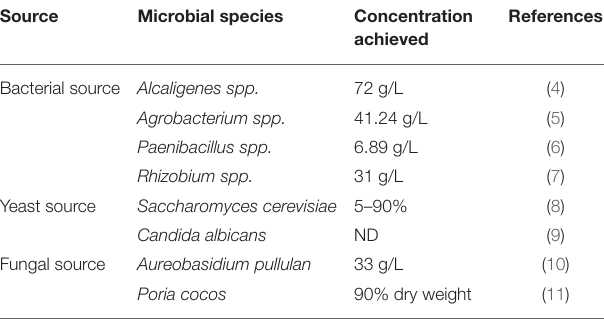
TABLE 2 | Microbial species used in the biosynthesis of curdlan and the yields achieved by different species.